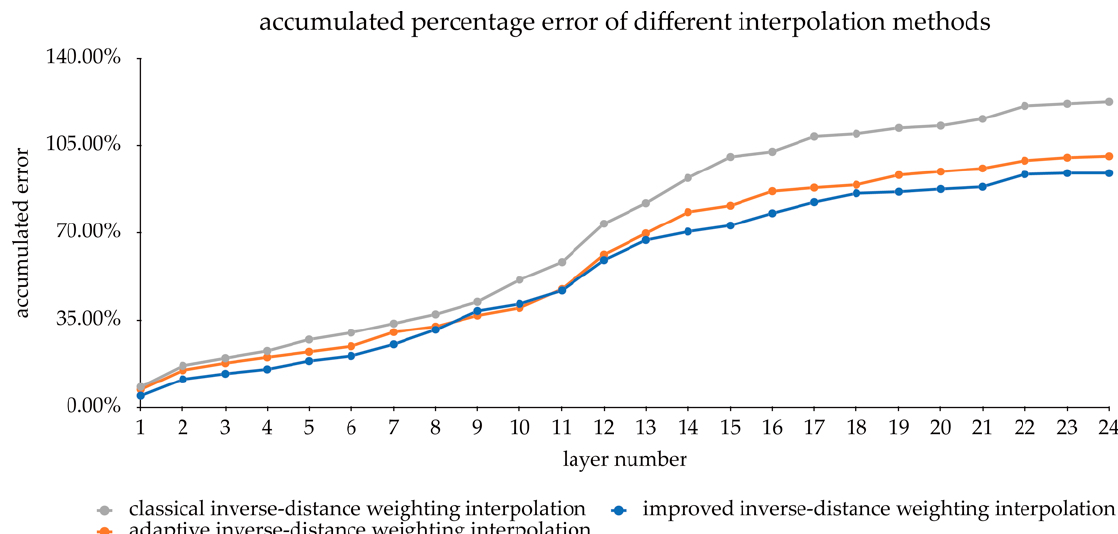
Figure 10. Accumulative percentage error of different interpolation methods. Similarly, the efficiency of the adaptive inverse-distance weighting interpolation method is compared with the existing improved inverse-distance weighting interpolation method and the classical inverse-distance interpolation method. Figure 11 shows the cumulative time required to complete the interpolation process. When the number of layers is relatively small, due to the relatively simple shapes of the geological bodies, the efficiency of the adaptive inverse-distance weighting interpolation method is the same as that of the classical inverse-distance interpolation method. With the gradual increase in the number of strata, the shapes of the geological bodies become increasingly complex. The adaptive inverse-distance weighting interpolation method can effectively suppress the time required for interpolation while maintaining an approaching accuracy with the improved inverse- distance weighting interpolation method and thus has a higher interpolation efficiency. At the end of the interpolation process, the classical inverse-distance interpolation algorithm requires 282.35 MS to complete the entire interpolation process, the adaptive inverse- distance interpolation algorithm requires 21.07% more, and the improved